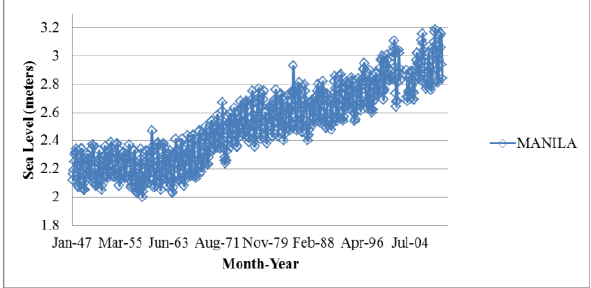
Figure 3. Monthly sea level records at the Manila South Harbor station.